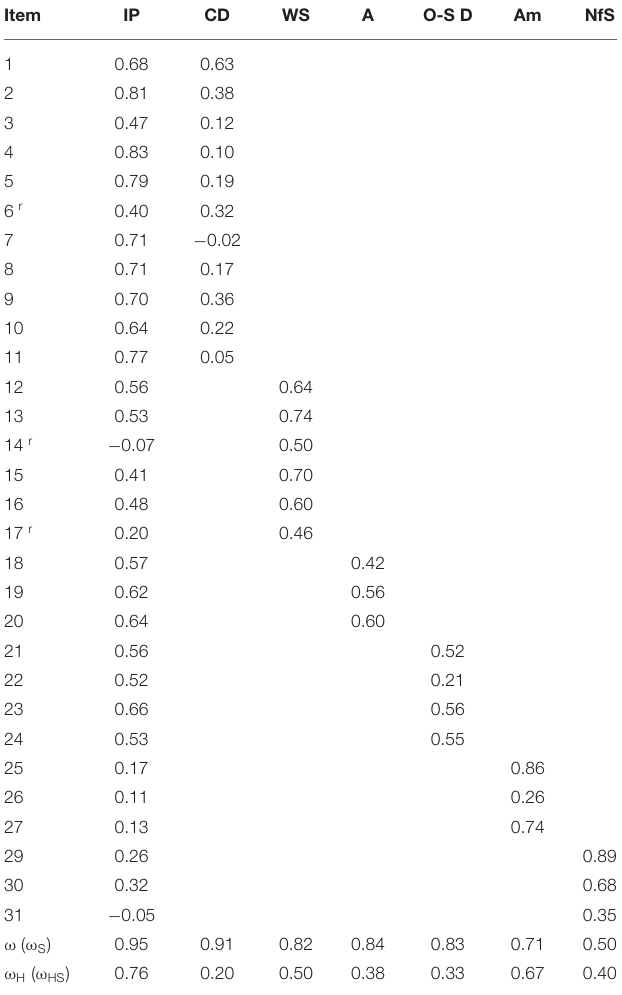
TABLE 3 | Standardized factor loadings and Omega coefficients of the bifactor model.